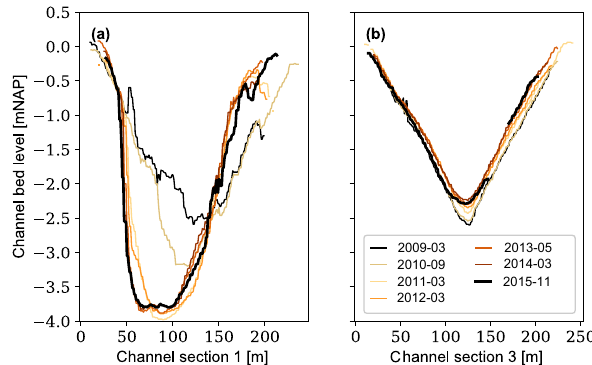
Figure 4. Bed level of channel section 1 (a) and 3 (b) for all moni- toring campaigns (see Fig. 1 for the locations of the cross